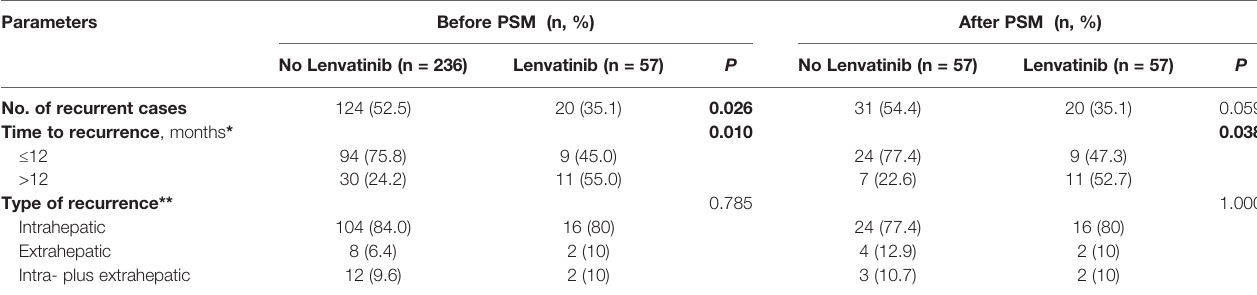
Bold values indicate statistical signi fi cance (P < 0.05). HCC, Hepatocellular Carcinoma; PSM, propensity score matching.